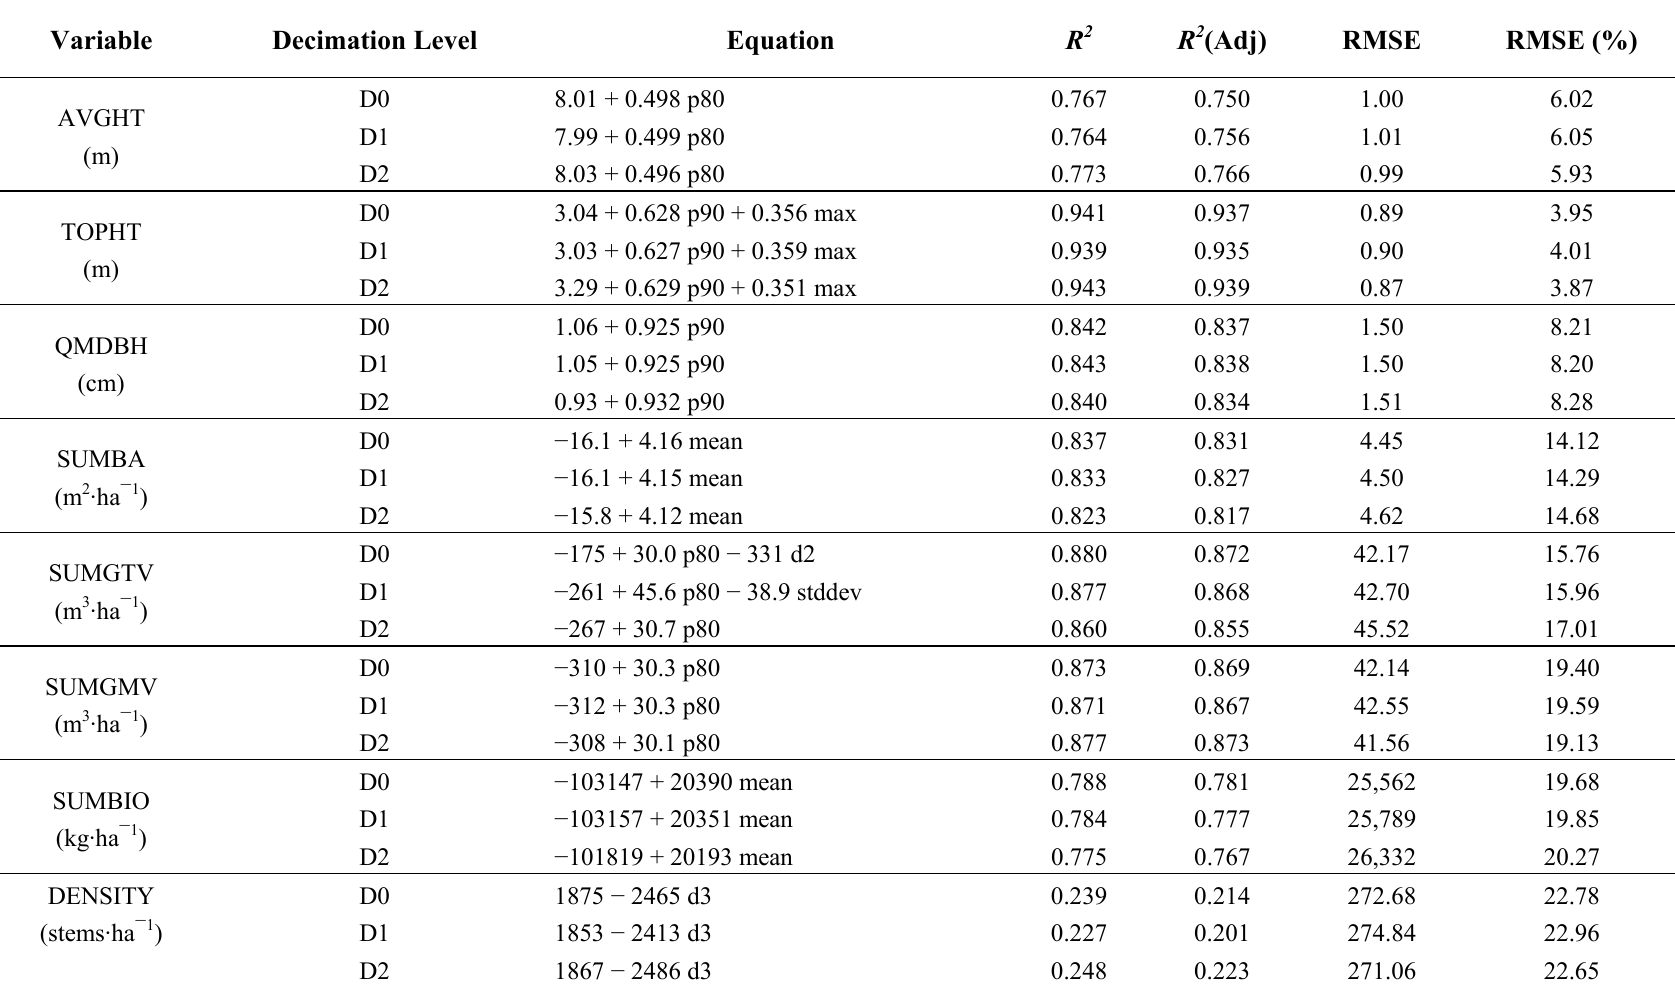
Table 4. Models (and associated statistical descriptors) developed for variables, based on intolerant hardwood plots in the RMF. Models are presented for each of the decimation levels ( i.e. , D0 ~ 3.2 pulses m − 2 ; D1 ~ 1.6 pulses m − 2 ; D2 ~ 0.5 pulses m − 2 ). Similar sets of models were developed for SLRF (Tol-Hwd), PRF (GrtLks-Pine), and RMF (Boreal-PJ, Boreal-SB, Boreal-IH and